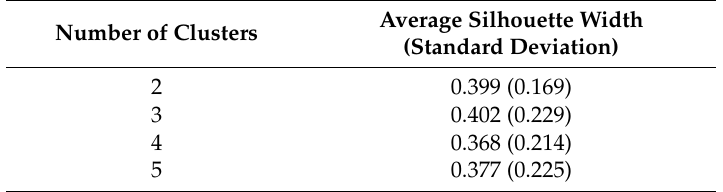
Table 4. Average silhouette width for the hierarchical clustering of provinces.